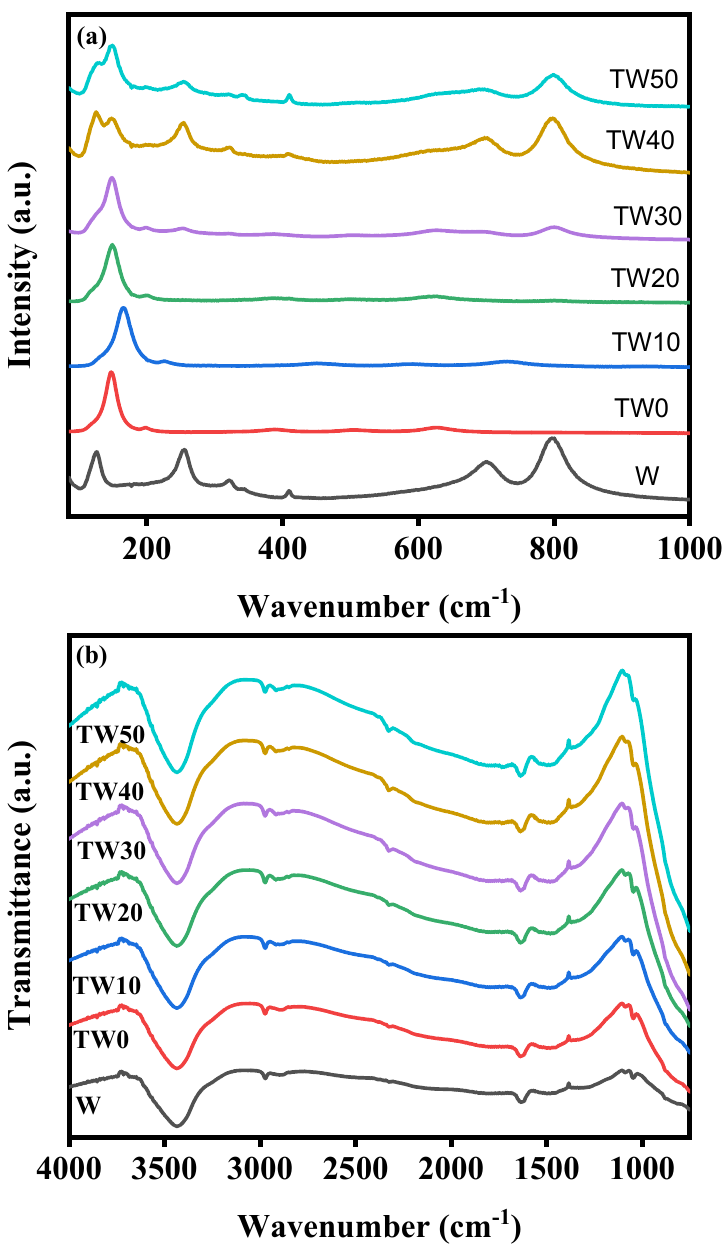
Figure 2. ( a ) Raman spectra and ( b ) FTIR for TW0, TW10, TW20, TW30, TW40 and TW50 nano- fibers.